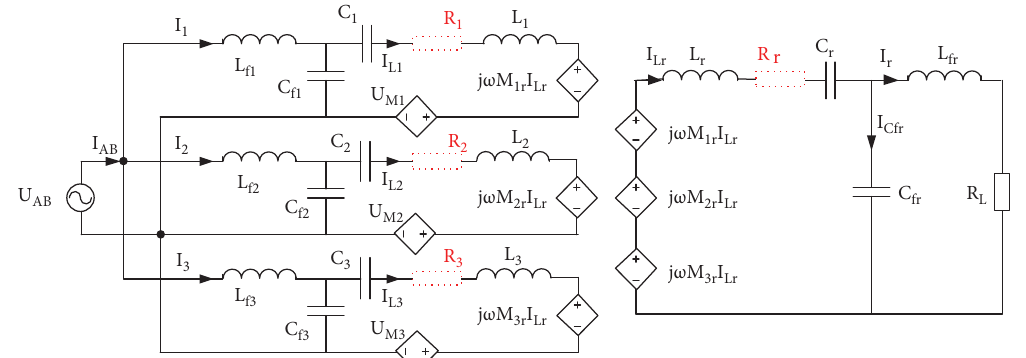
Figure 4: Equivalent circuit of the coupling system.